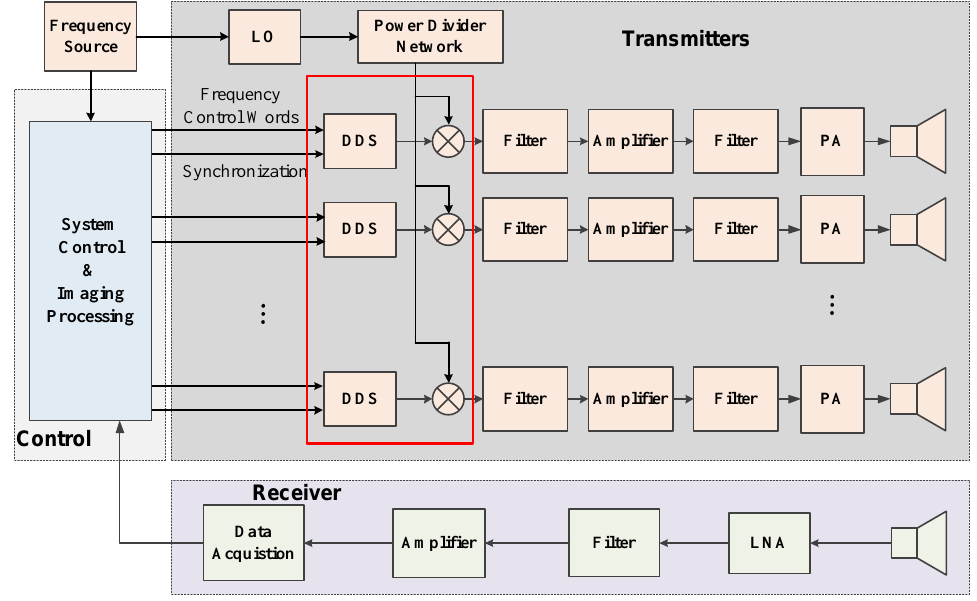
Figure 3. A typical system diagram of conventional MSCI emitting random frequency-hopping waveforms. LO—Local Oscillator; DDS—Direct Digital Synthesis; PA—Power Amplifier; LNA—Low Noise Amplifier.